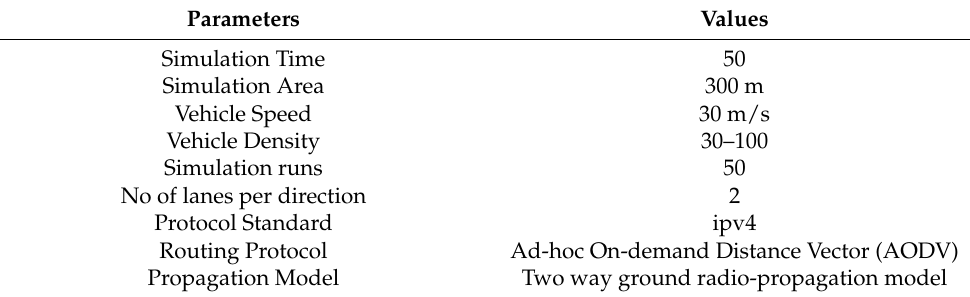
Figure 6. Sample screenshots in NS2. Table 1. Simulation